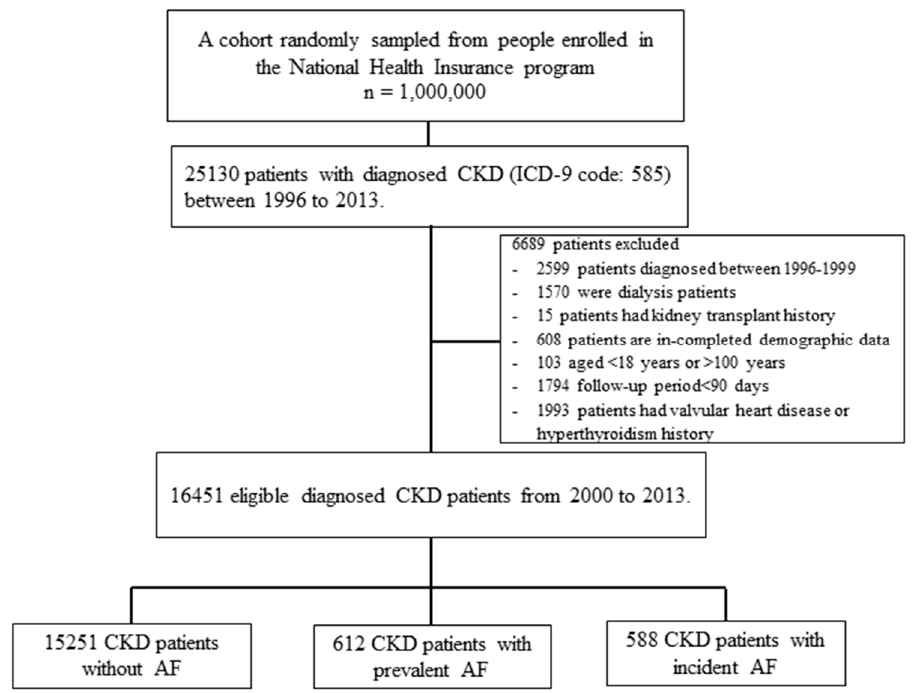
Figure 1. Flowchart of patient selection processes for incident chronic kidney disease (CKD) with non-atrial fibrillation (AF), prevalent AF, and incident AF.